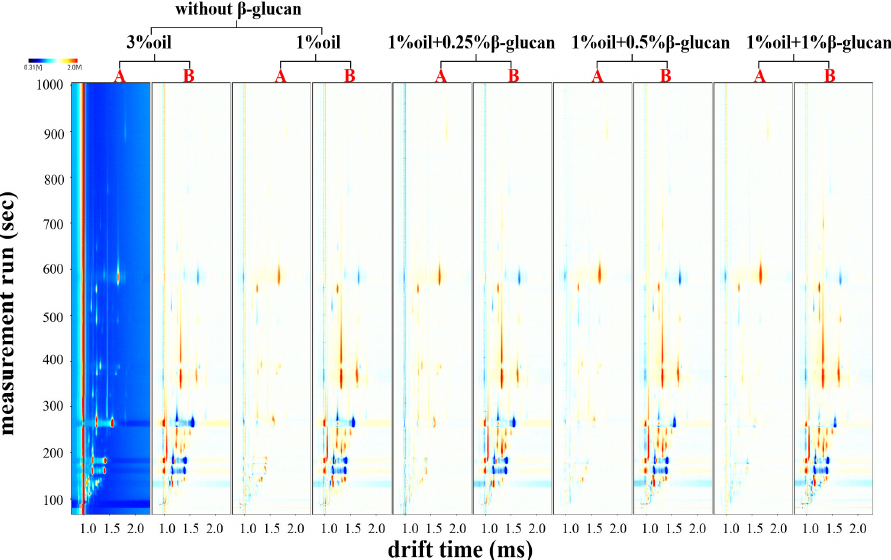
Figure 5. Effect of oat β -glucan concentration on the two-dimensional difference spectra of VOCs before and after fermentation: A and B represent the samples with or without fermentation, respec- tively.